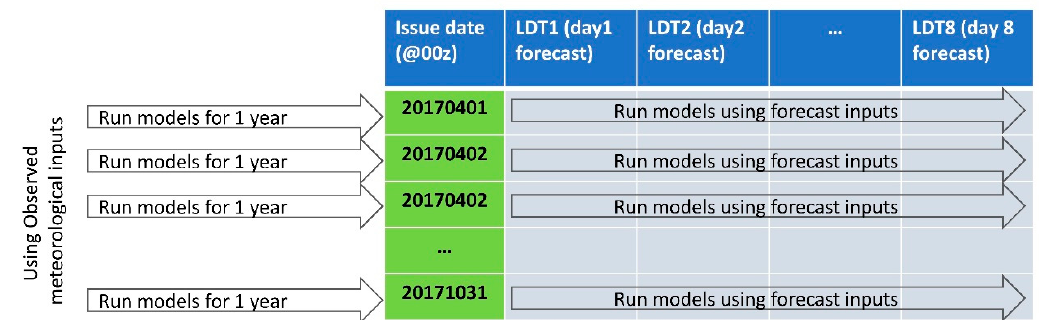
Figure 4. Model update and forecast in the hindcast period.